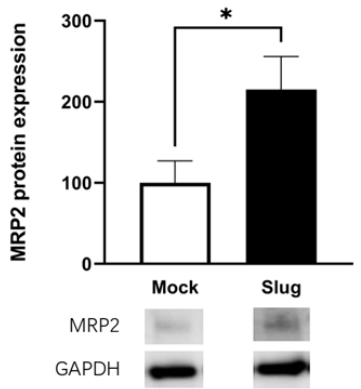
Figure 3. Protein expression levels of MRP2 and Slug in Mock- and Slug-transfected HCC827 cells. The protein expression level of MRP2 was also significantly increased in Slug-transfected cells (n = 4, * p < 0.05). Western Blotting data represented the mean ± SD.